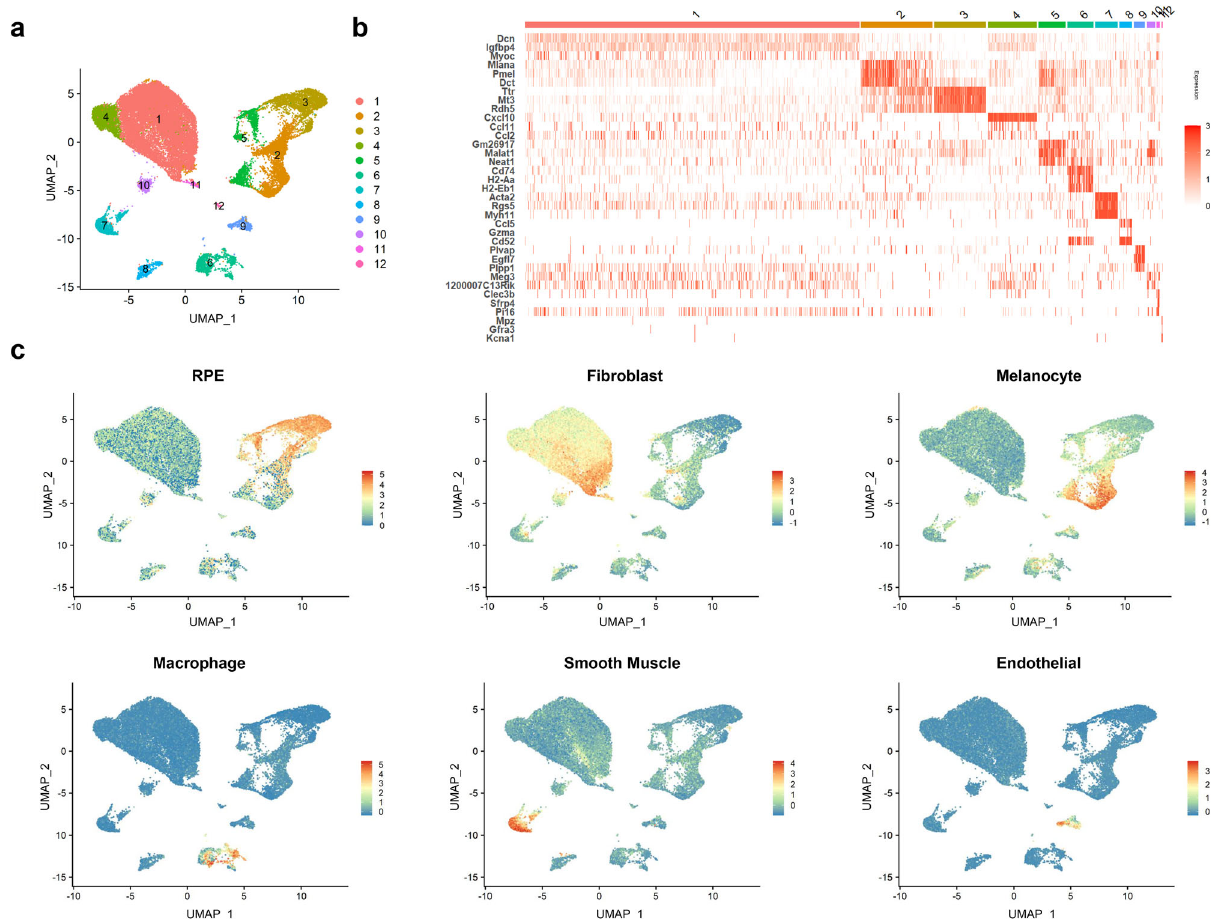
Fig. 1 scRNA-seq analysis of whole isolated cells yielded 12 distinct cell populations. a UMAP plot depicting the single-cell transcriptomes of whole cells from prepared RPE tissues from control and Dox-treated mice. Each dot represents a single cell ( n = 35,598). Colorization was performed according to the unsupervised clustering performed by Seurat. b Heatmap showing the three most DEGs of each cell cluster, as provided by Seurat. Each column represents a single cell, and each row represents an individual gene. Three marker genes per cluster are shown on the left, sorted by p value. Red indicates maximum gene expression, and white indicates no expression in scaled log-normalized UMI counts. c Average expression of well-established cell type markers was projected on the UMAP plot to identify all cell populations (see the “ Methods ” for details). Red indicates maximum gene expression, while blue indicates low or no expression of a particular set of genes in log-normalized UMI counts. Table 1 Number of cells in each cluster of control retinal pigment epithelium cells and low-dose doxorubicin-treated cells.